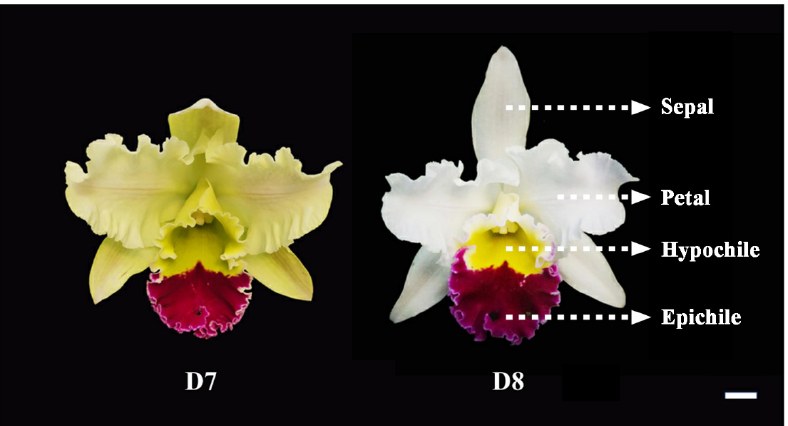
Figure 1. KOVA flowers during flowering. According to a previous study [25], KOVA flowers at developmental stages 7 (D7) and 8 (D8). The structure of a KOVA flower ( right picture ). The KOVA flower is scentless and fragrant at D7 and D8, respectively. Bar = 1 cm.